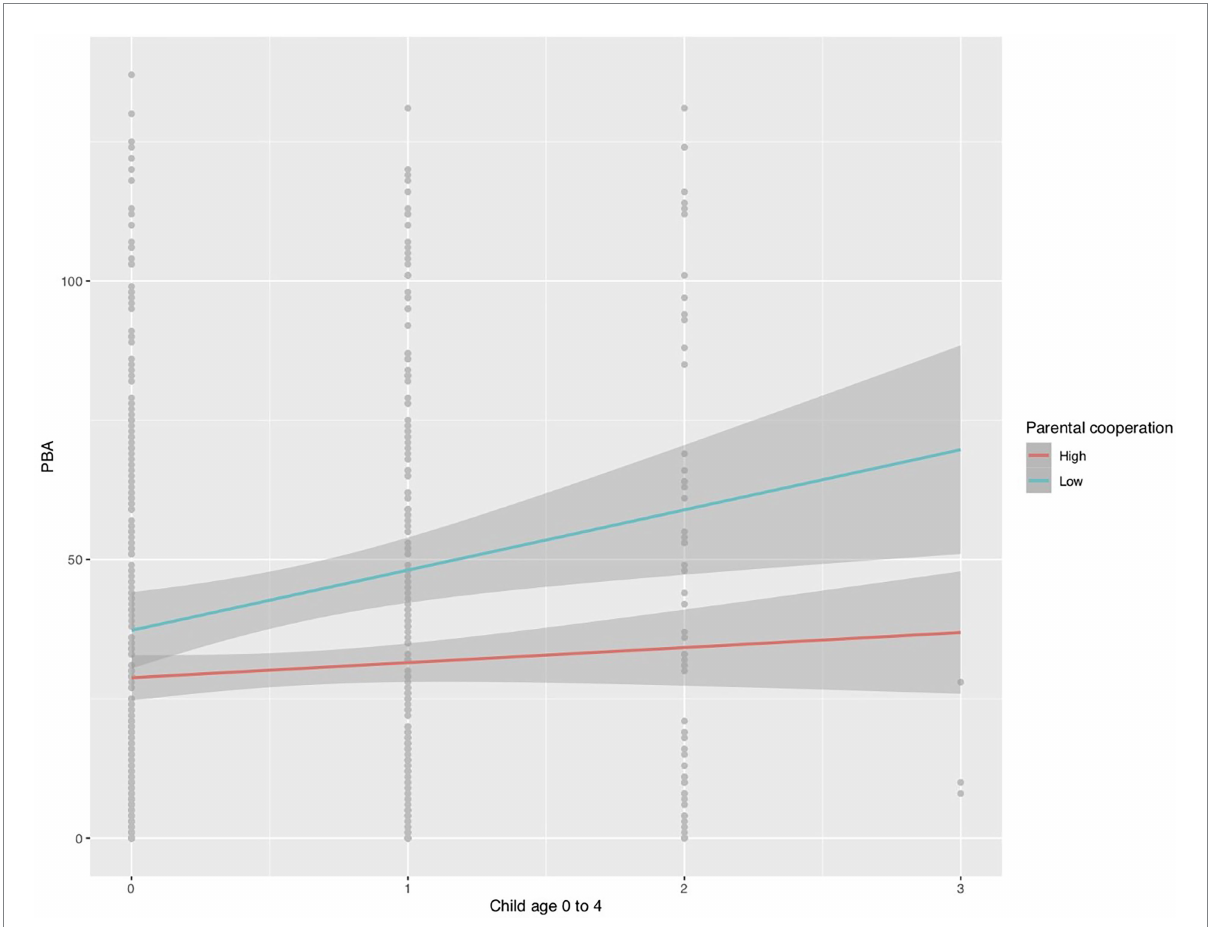
FIGURE 1 Moderation of the PB in the face of co-parent cooperation. Greater coparental cooperation (red line) results in lower PBA scores for parents with children aged 0–4 years compared to parents with low co parental cooperation (blue